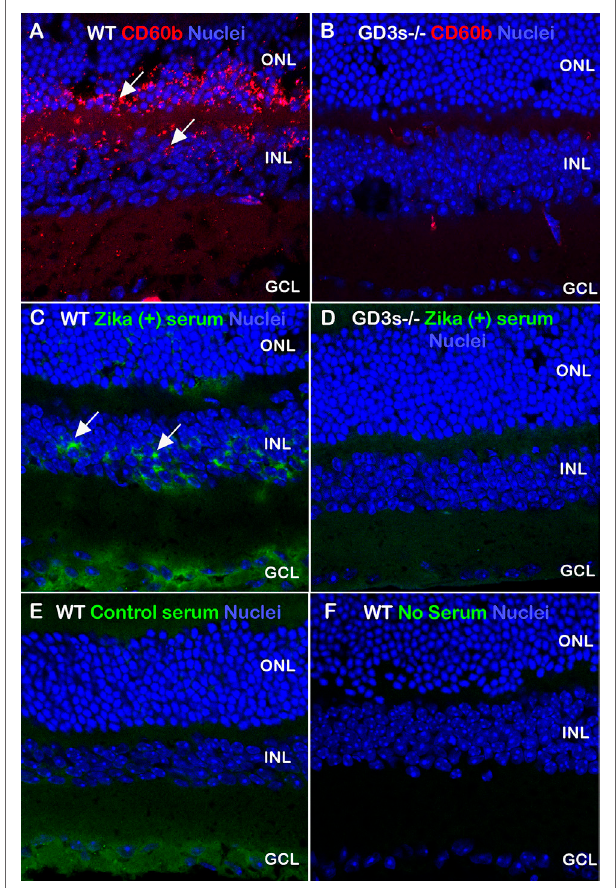
FigUre 2 | Autoantibody profile in Zika-infected patients recognizing GD3 gangliosides from retinal tissue. Retinal sections obtained from wild-type and GD3-deficient mice were stained with control antibody (CD60b, red) to detect the 9- O -acetylated form of GD3 ganglioside. Serum derived from Zika patients (a,c,e) recognized antigens (green) in the wild-type retina, more abundantly in the inner nuclear layer (arrows). Control healthy serum (b,D,F) did not recognize antigens in the outer and inner nuclear layers in which GD3 is largely expressed. A level of serum reactivity for the ganglion cell layer was noticed in wild-type sections exposed to both human sera groups. Images are merged with nuclei (TOPRO,